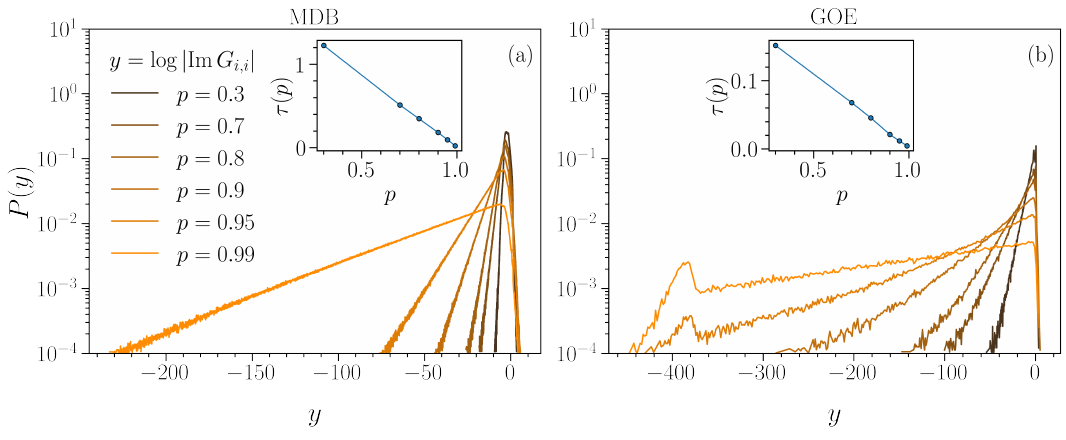
Figure 6: Histograms of the retarded Green functions at ω = 0 of an L = 512 Anderson model with W = 4, for various values of p in the MDB protocol (a) and the GOE one